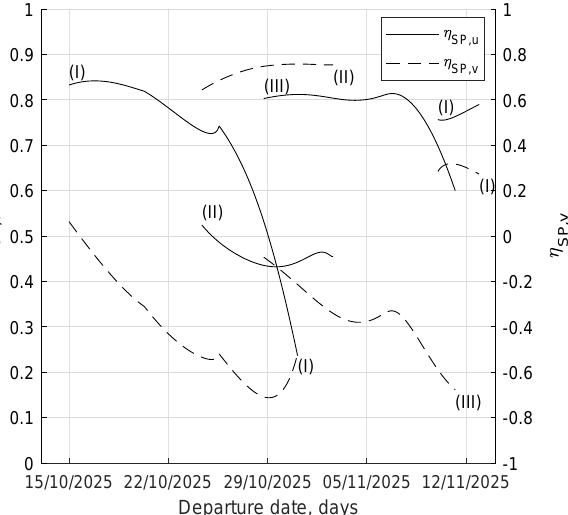
Figure 17. Radial and tangential overall perturbation effect per trajectory for escapes from